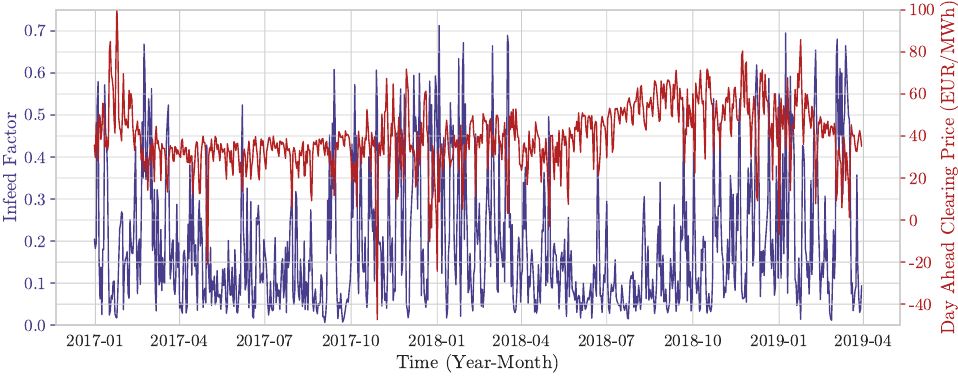
Figure 1. German wind infeed and Day Ahead spot prices from 2017 until spring 2019. Infeed is scaled as a factor of total available capacity. Periods of common high volatility are